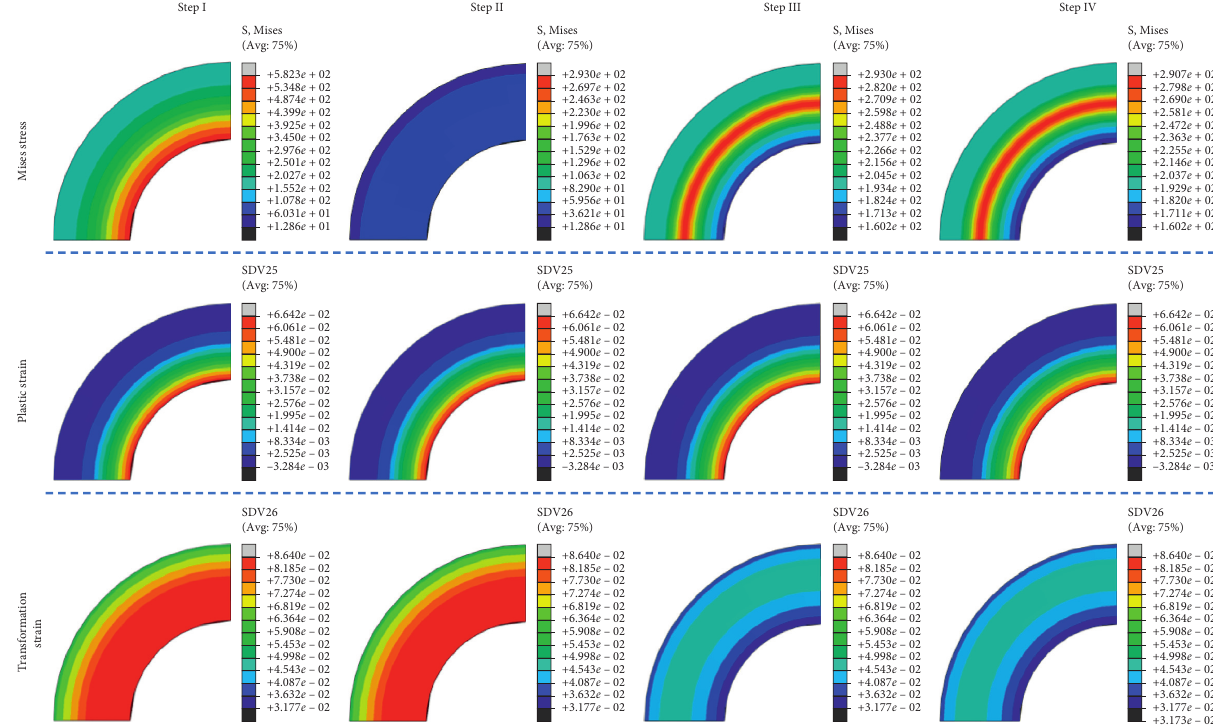
Figure 11: The distributions of von Mises stress, plastic strain, and transformation strain in different steps (J1-P3